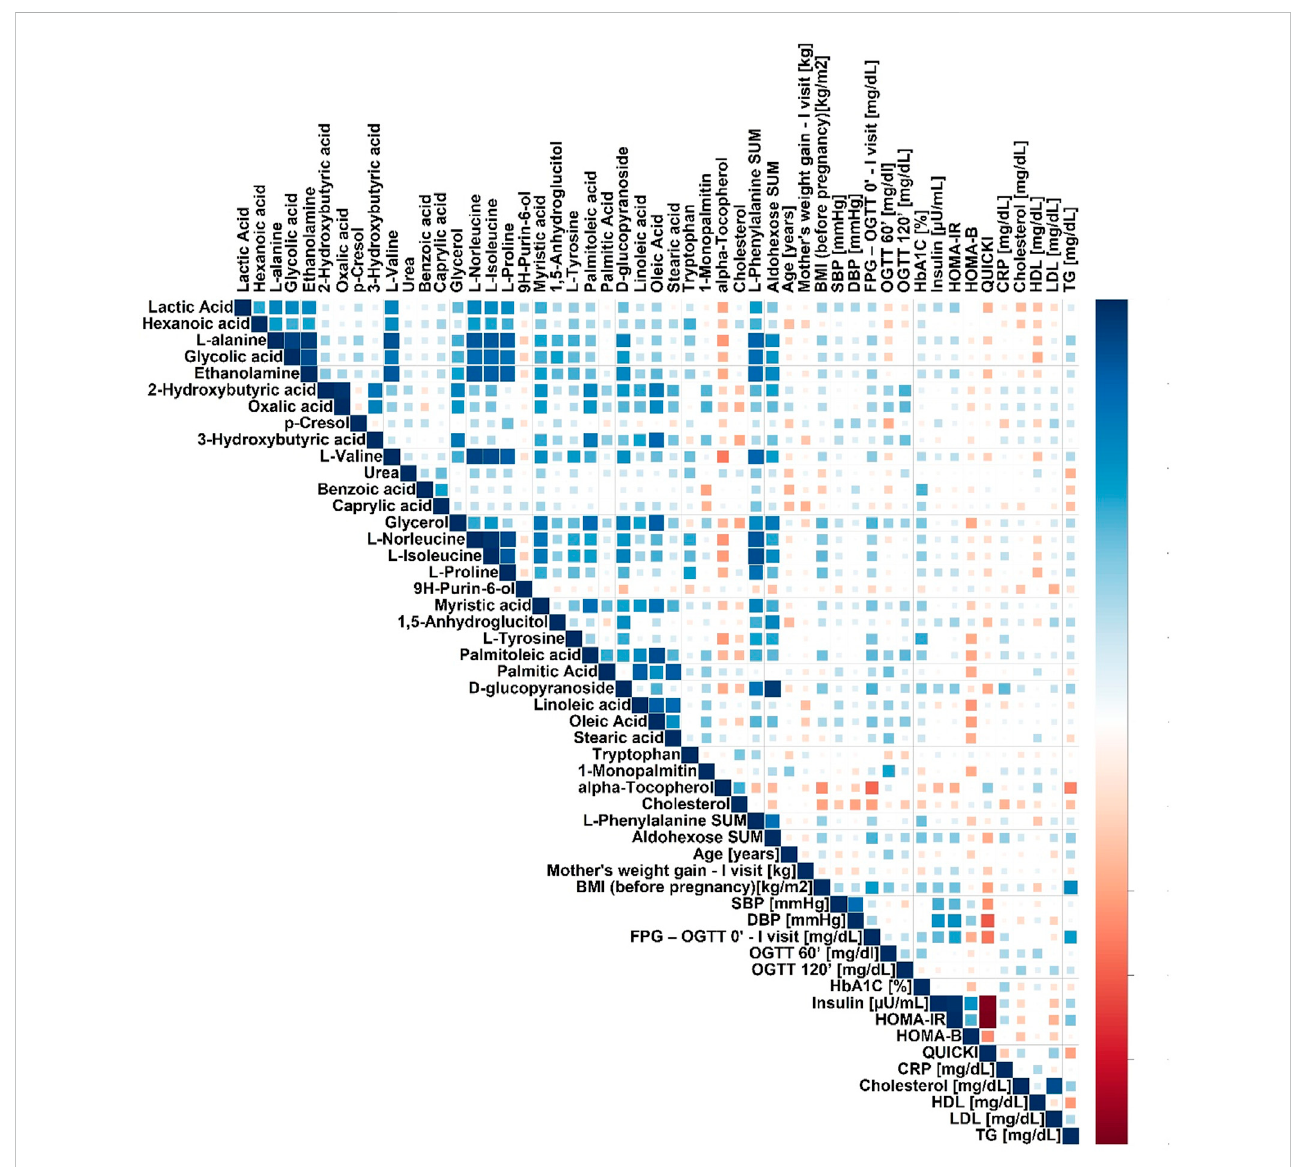
FIGURE 2 Spearman ’ s correlation heatmap for metabolites in plasma signi fi cantly changed in pregnant GDM versus NGT women.